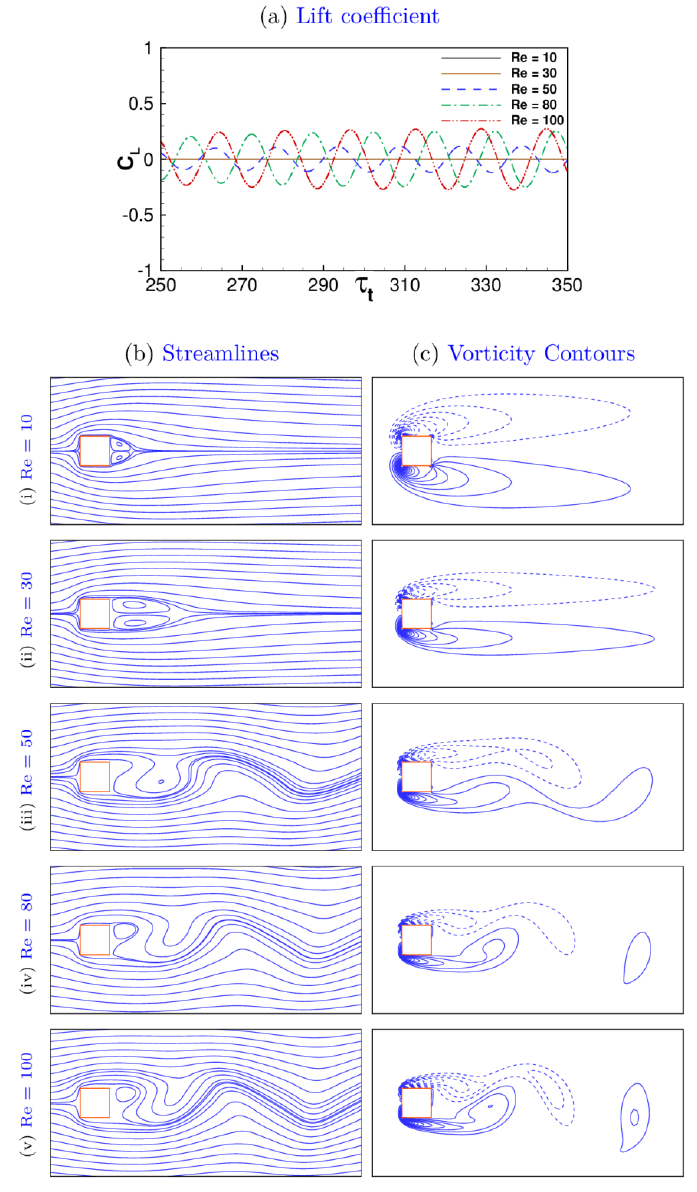
Figure 2. ( a ) Time evolution of lift coefficient (C L ), ( b ) instantaneous vorticity contours, and ( c ) streamlines for different values of Re at Ri = 0 and φ = 5%.